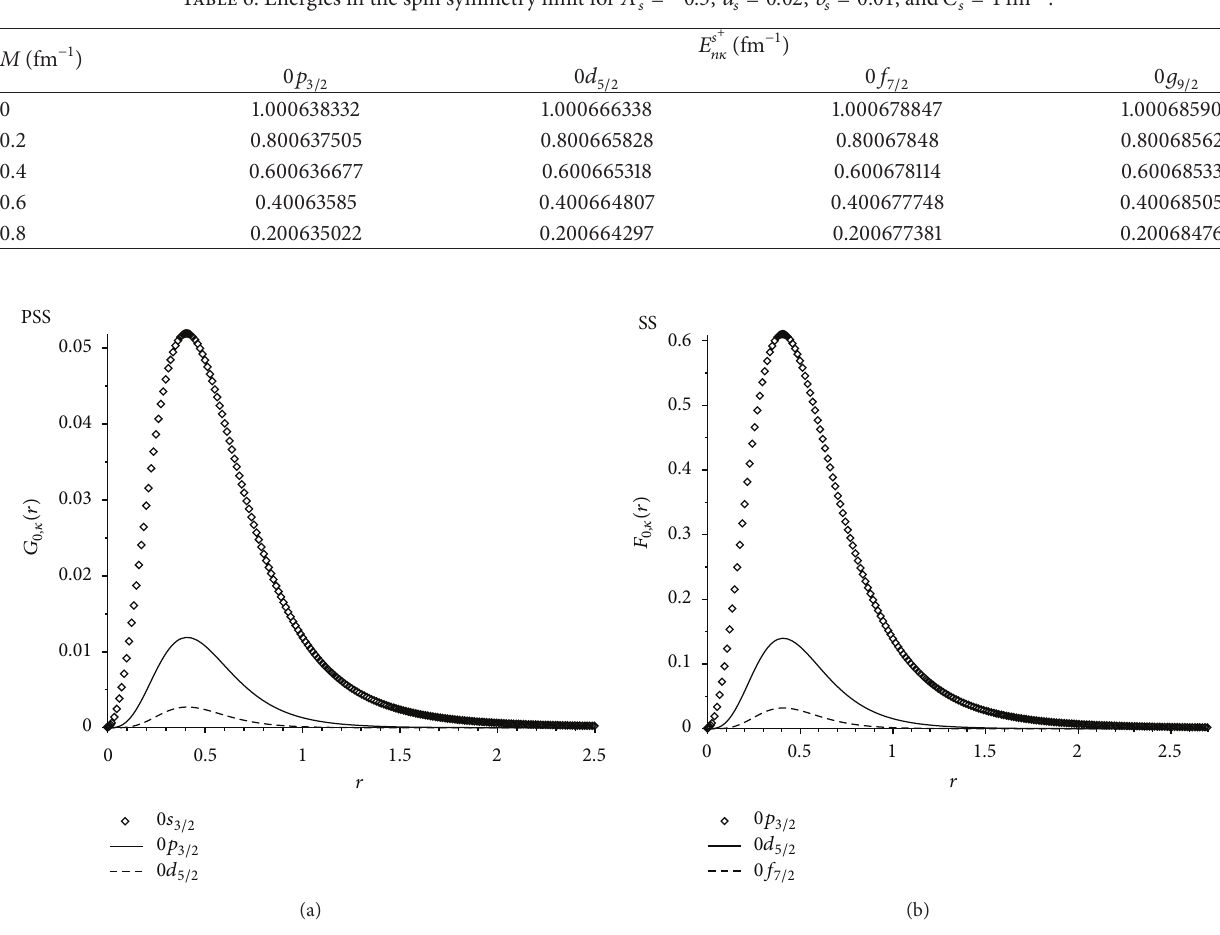
= −0.5 , 𝑎 = −0.02 , 𝑏 = 0.01 , 𝑀 = 0.5 fm −1 , and 𝐶 ps ps ps